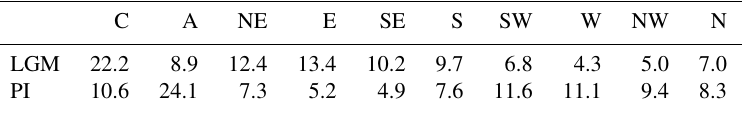
Table 2. Circulation weather type occurrence frequencies (%) for central Europe (centred at 17.5 ◦ E and 47.5 ◦ N) during the LGM and the pre-industrial period (PI). The frequencies are based on the LGM and the PI simulation of the Max Planck Institute Earth System Model. The circulation weather type classes are cyclonic (C), anticyclonic (A), northeasterly (NE), and easterly (E) followed by the remaining standard wind directions. C